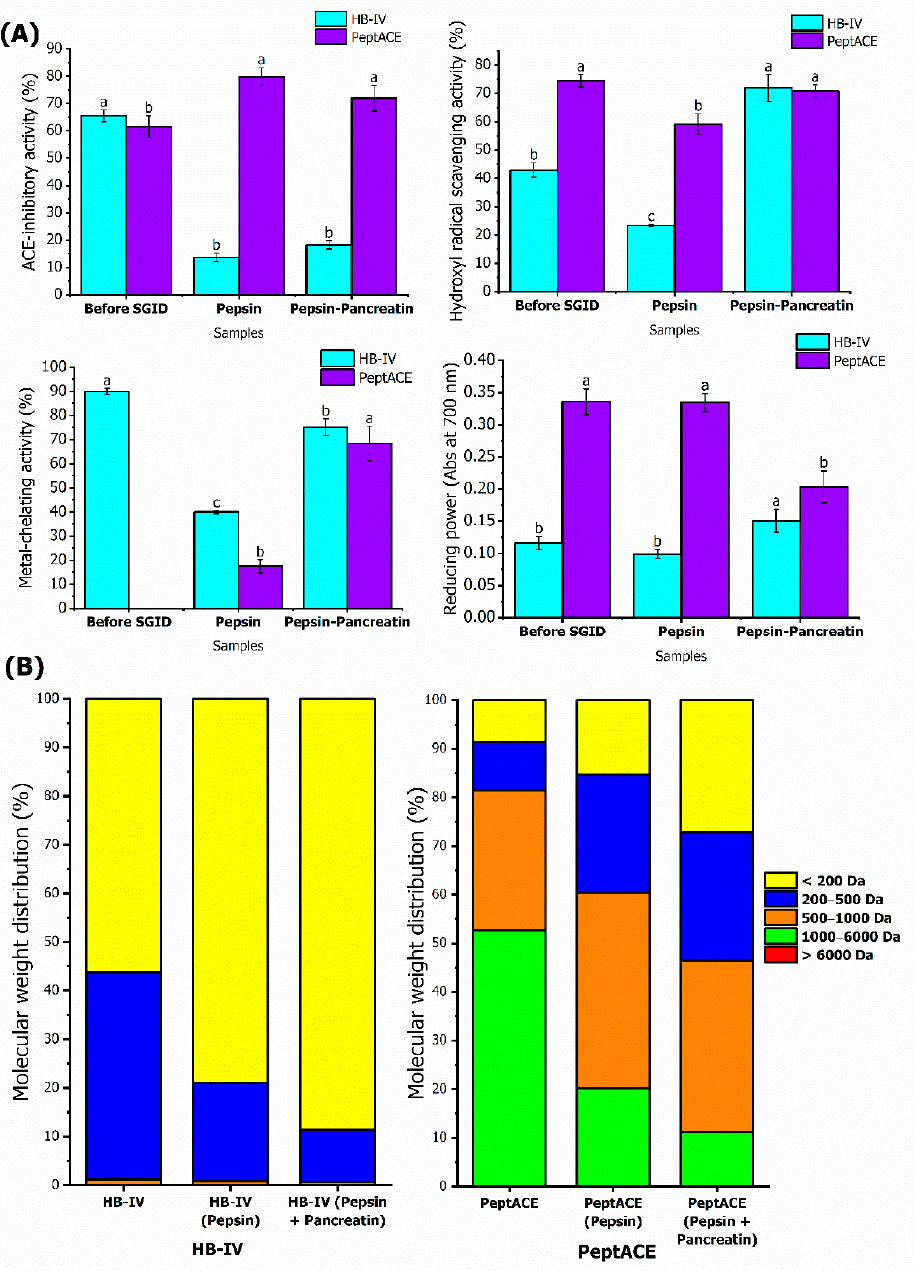
Figure 5. The effect of in vitro stimulated gastrointestinal digestion on HB-IV and PeptACE. ( A ) The bioactivities of HB-IV and PeptACE during SGID. ( B ) The molecular weight distribution of HB-IV and PeptACE before and after SGID. The values represent the mean ± SD. Means without a common letter (a–c) on the bars indicate significant difference at p < 0.05. As depicted in Figure 5A, ACE ‐ inhibitory activity of HB ‐ IV dropped 4.8 times to 13.70% ( p < 0.05) after going through pepsin digestion, and after increased slightly ( p > 0.05) until the end of SGID. This showed that SGID resulted in peptides with weaker ACE ‐ inhibition capacity. PeptACE has a completely opposite trend to HB ‐ IV, its ACE ‐ inhibi ‐ tion potency increased significantly ( p < 0.05) after pepsin digestion, and maintained after pancreatin digestion. At the end of SGID, HB ‐ IV was reported to have four times lower